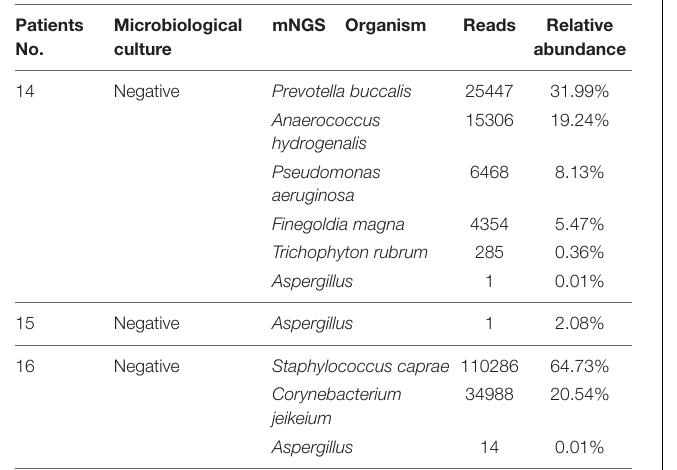
FIGURE 2 | The relative abundances of Aspergillus in patients with different CT scores. * p ≤ 0.05.